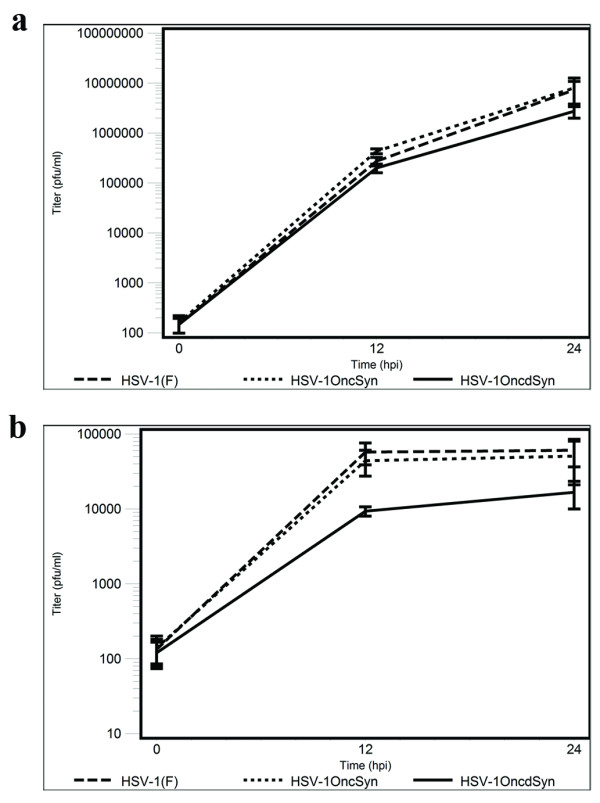
Comparative kinetics of viral replication of wild-type HSV-1(F) and mutant viruses OncSyn and OncdSyn grown on Vero and 4T1 cells. Near confluent monolayers of Vero (a) and 4T1 (b) cells were infected at an MOI of 2 with each virus, incubated at 37°C and the numbers of infectious virions were determined at different times post infection. Viral titers (mean pfu at each time point) are shown in logarithmic scale. The error bars represent means ± 2 standard errors.